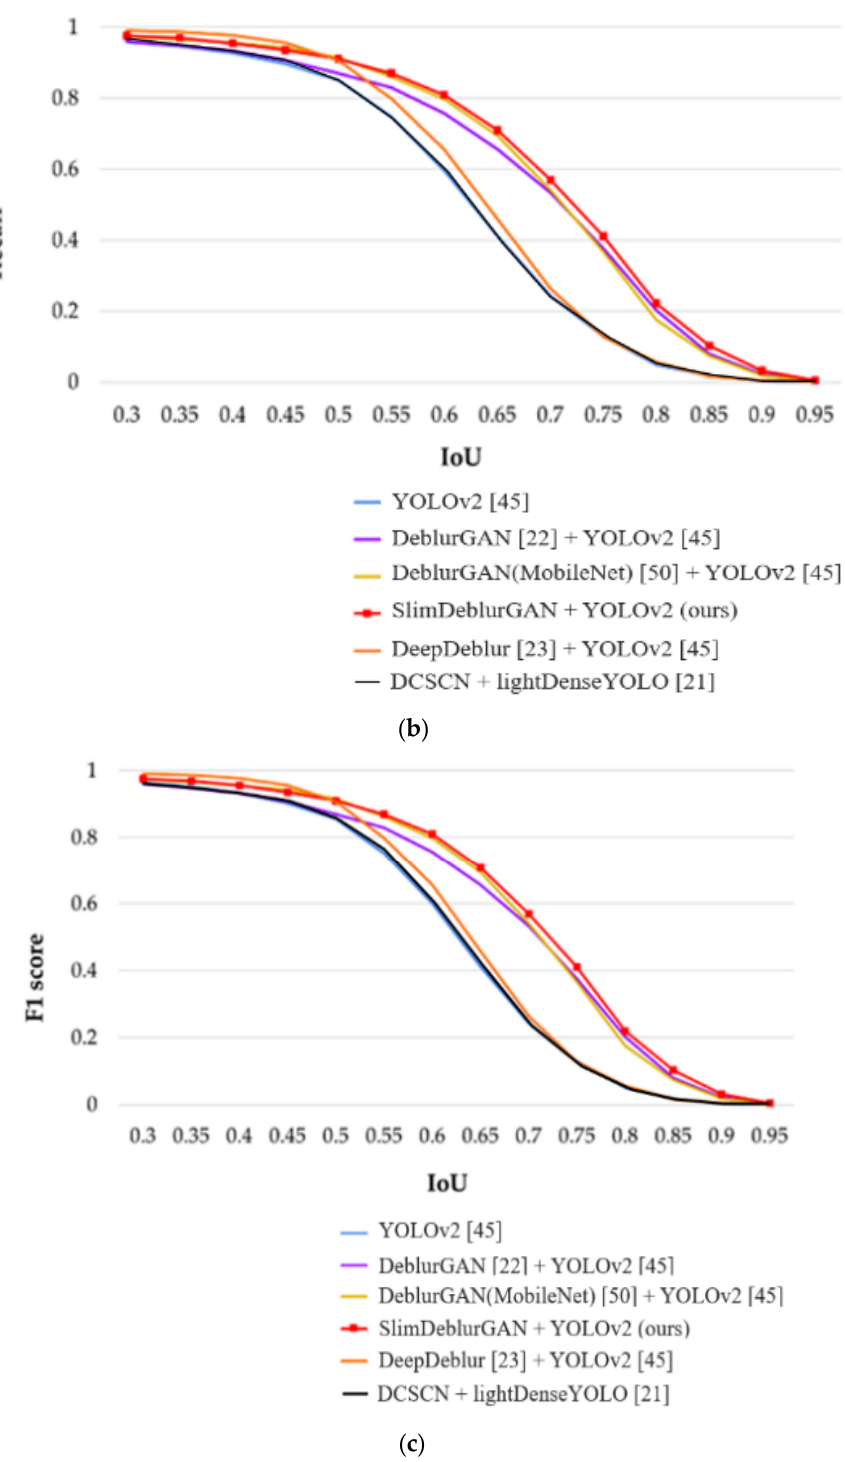
Figure 15. Marker detection results on RMBD-DB1 for five methods at different IoU thresholds: ( a ) precision, ( b ) recall, and ( c ) F1 score.